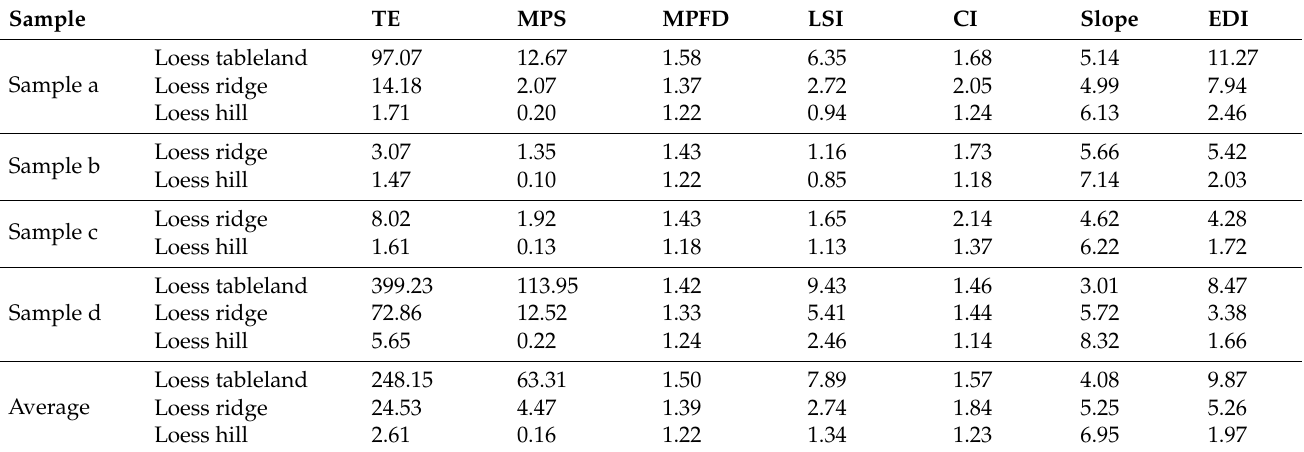
Table 5. 3D landscape pattern indices result of loess landform types.